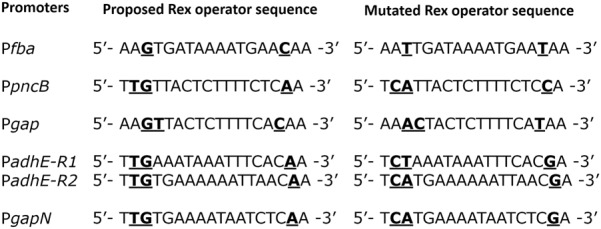
Aligned mutated and non-mutated Rex operator sequences in Pfba, PpncB, Pgap, PadhE, and PgapN.